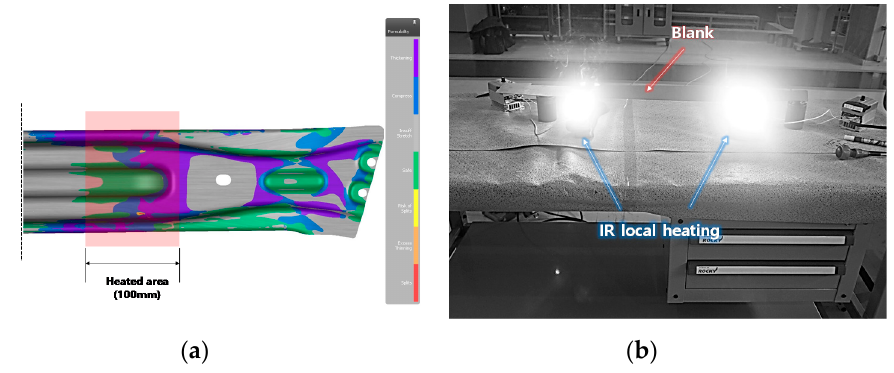
Figure 12. Heat treatment for the door impact beam application: ( a ) Heat treatment area on the left side of the door impact beam; ( b ) Heat treatment process.